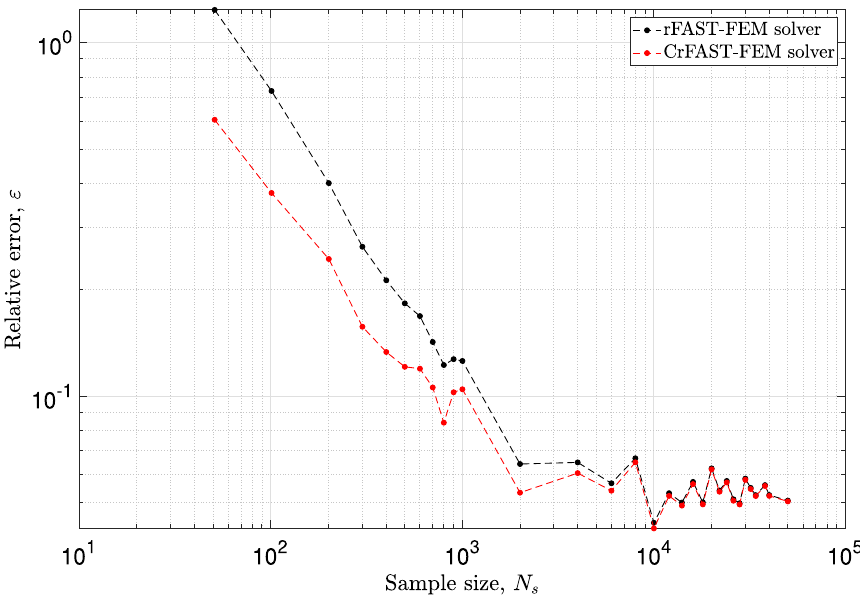
Fig. 6 Evolution of the relative error of Eq. (40) for the classical (black curve) and corrected estimation (red curve) of the rFAST-FE solver